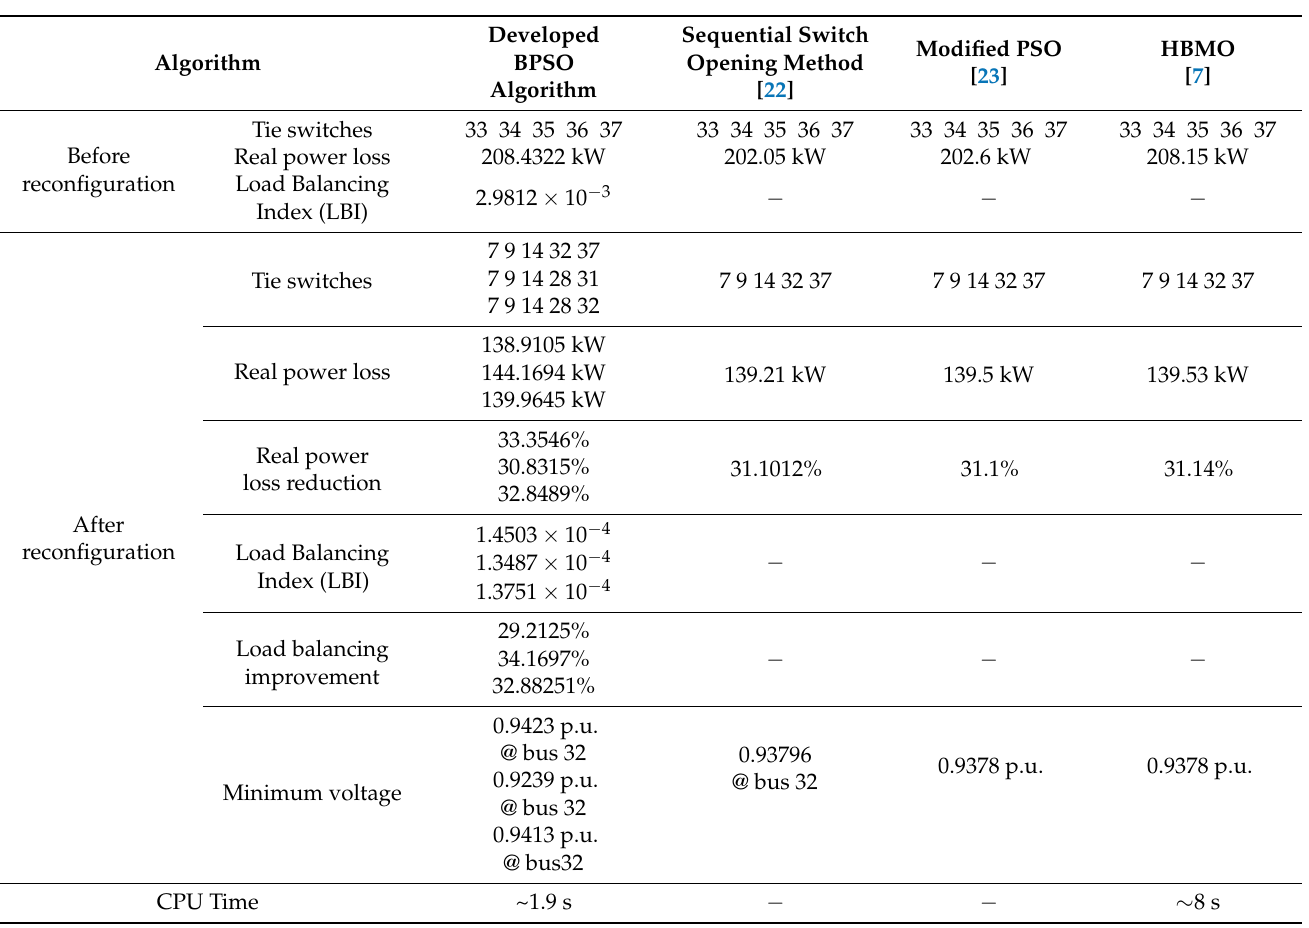
Figure 4. The 33-bus distribution system. Table 3. The simulation results of the 33-bus distribution system’s multi-objective feeder reconfiguration problem.